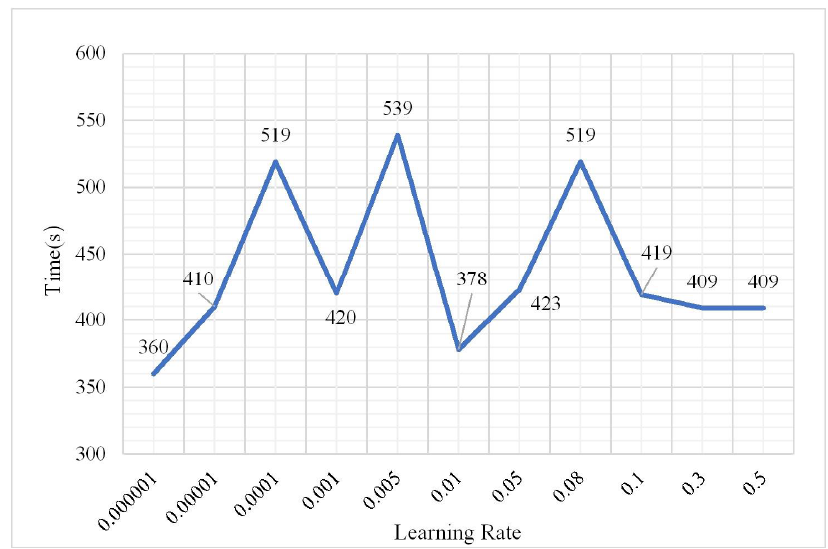
Plants 2021 , 10 , x FOR PEER REVIEW Figure 13. Change in kappa coefficient. Figure 13. Change in kappa coefficient.